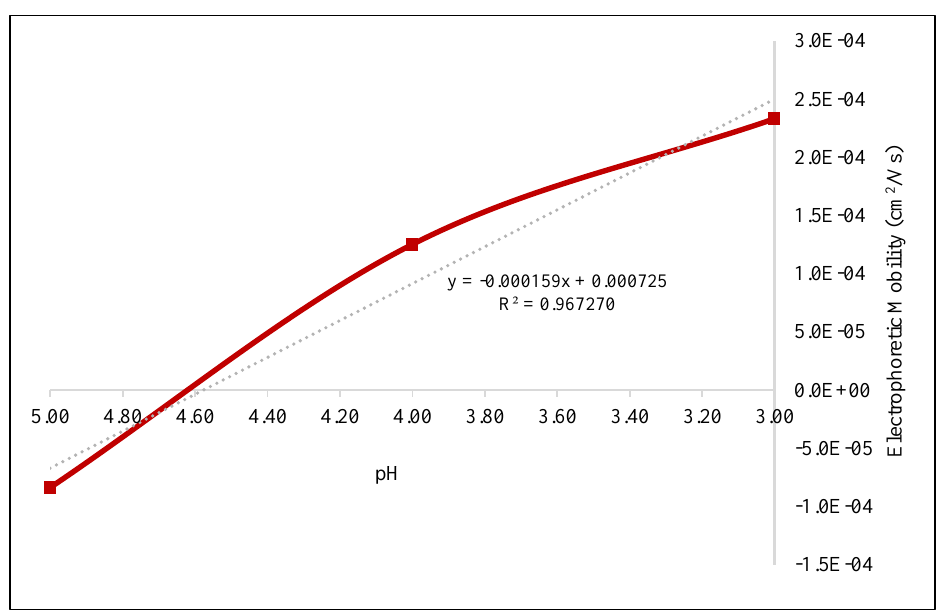
Figure 2. Graph of relationship between electrophoretic mobility value and pH of precipitation on red bean